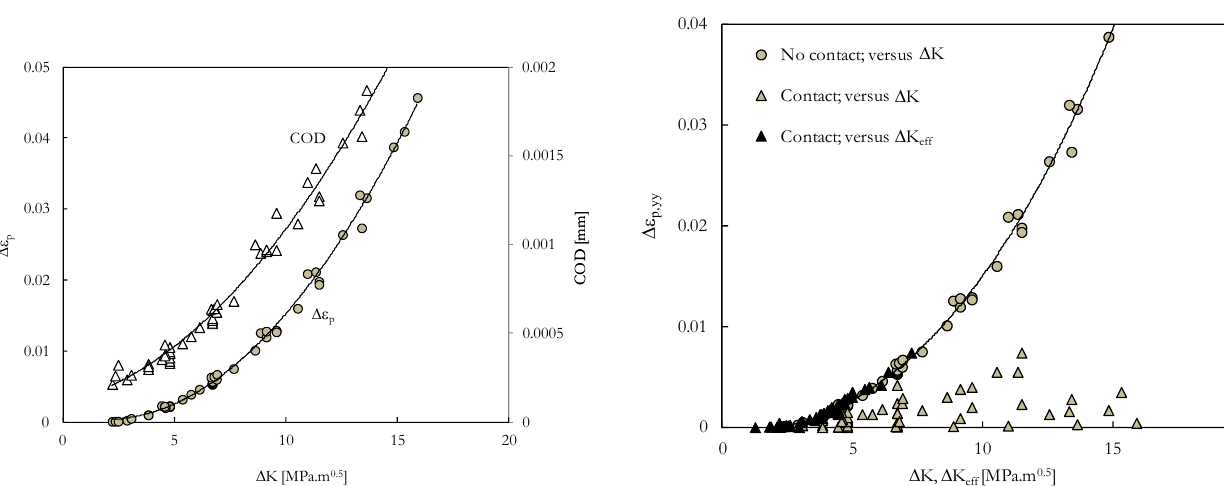
Figure 2: Effect of  K on range of plastic strain and crack opening displacement (no contact).